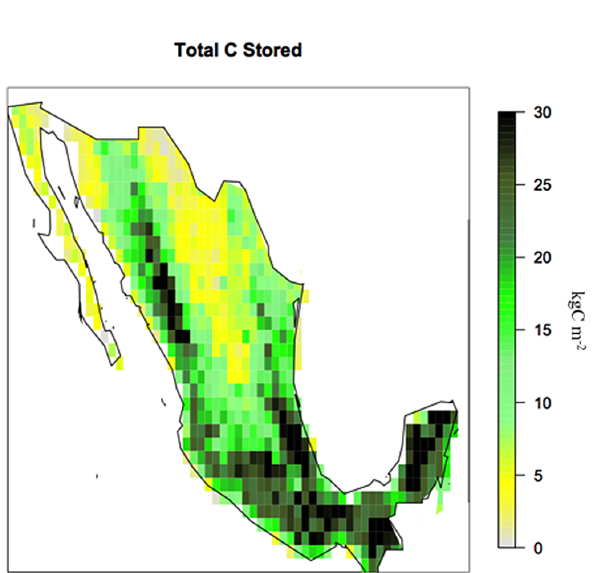
Figure 3. Total stored C in soil and vegetation (kgCm − 2 ) , ensem- ble from all products (6) for the period 2000–2005.